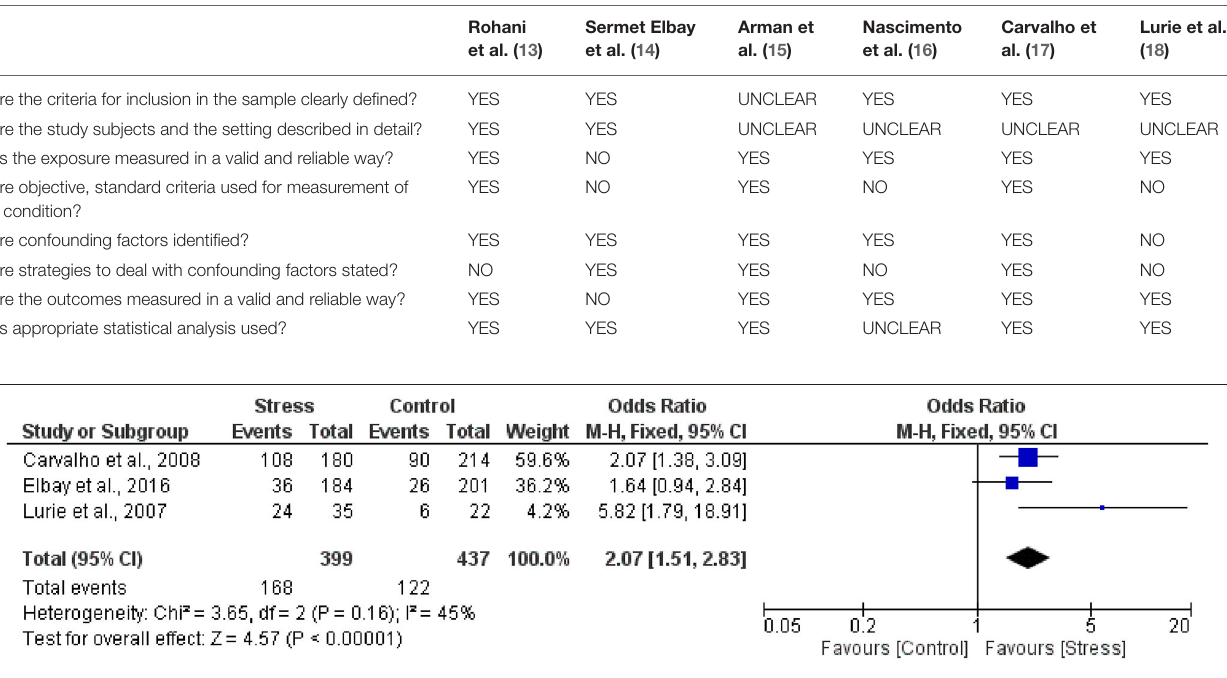
FIGURE 2 | Forest plot of association between stress and